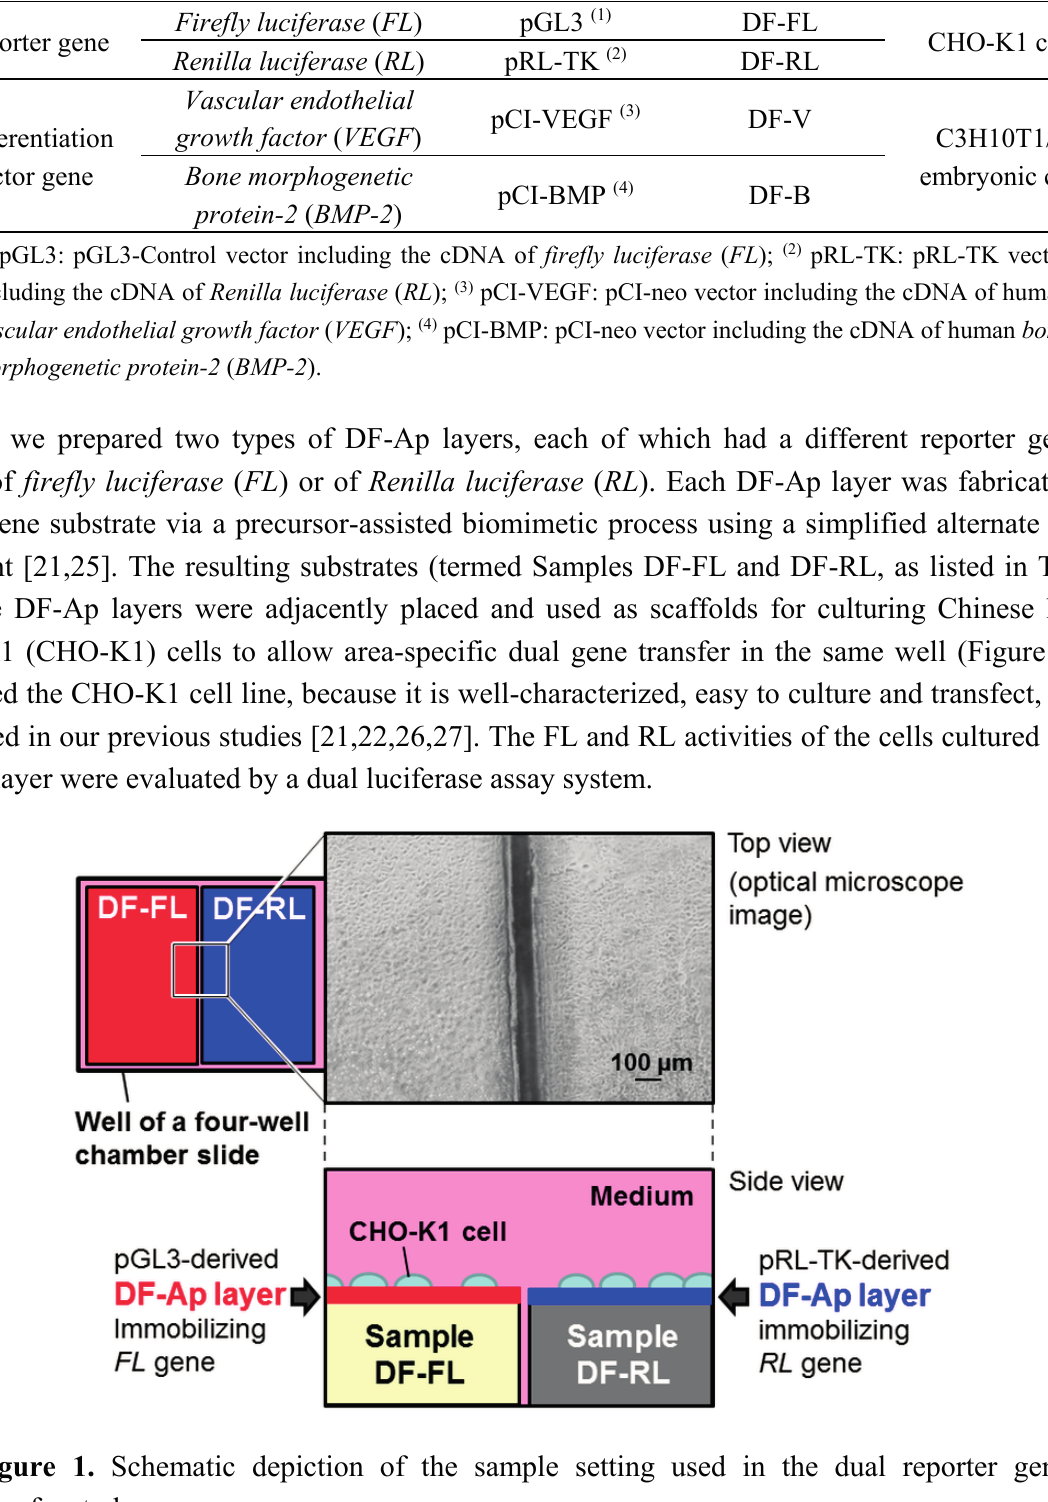
Table 1. List of the genes, plasmid DNAs, sample names, and cell lines used in this study. Type of Gene